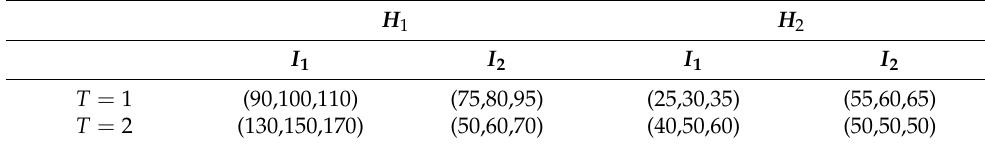
Table 2. Supply of WHs in different periods.